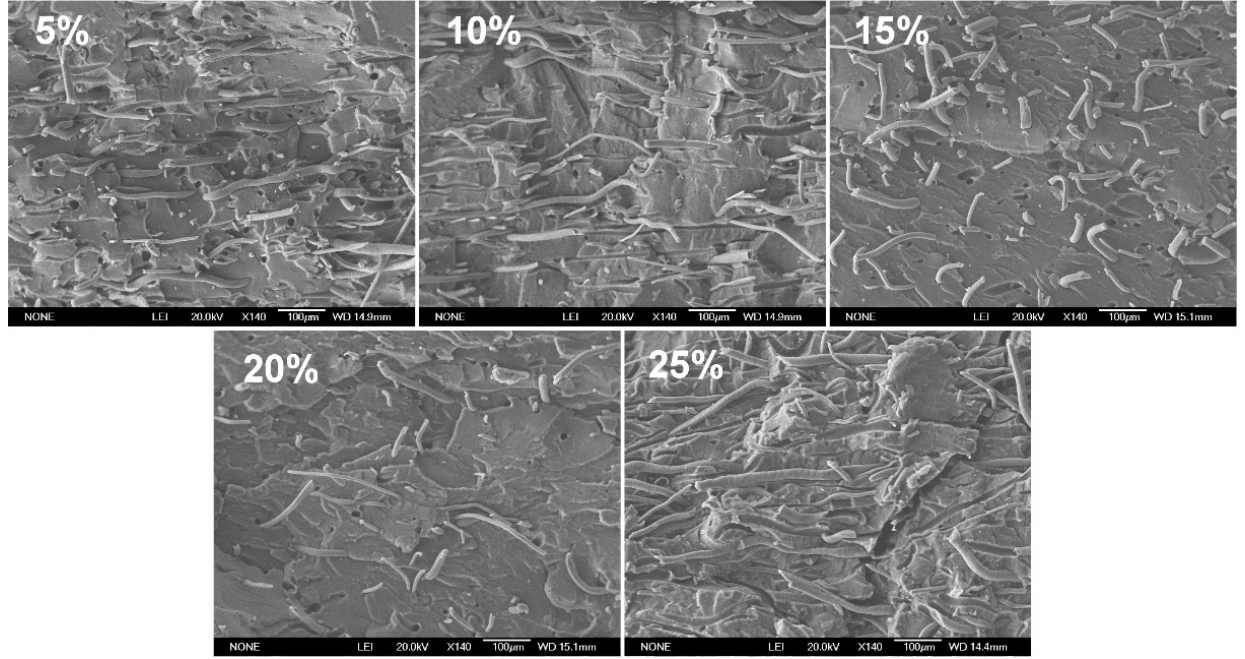
Figure 2. The SEM images of the fracture surfaces of RPE/WPF composites with different content of WPF (wt%).